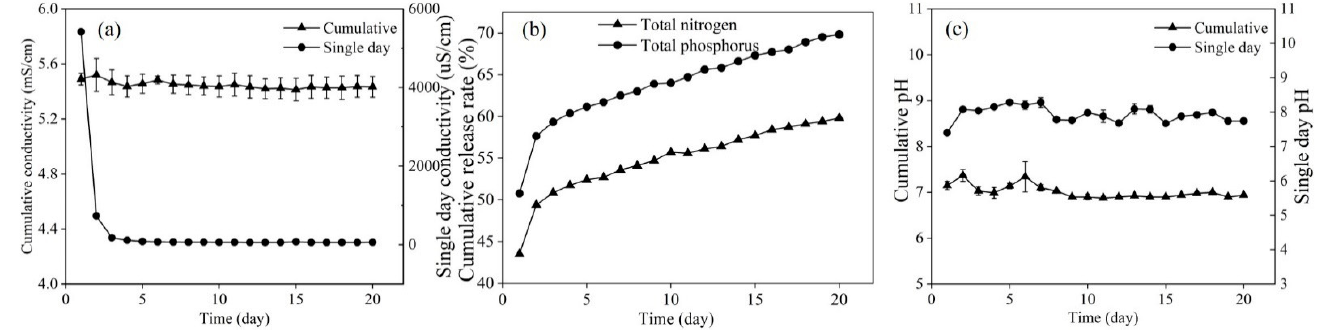
Figure 3. Conductivity ( a ), nutrient release ( b ), and pH ( c ) of the composite